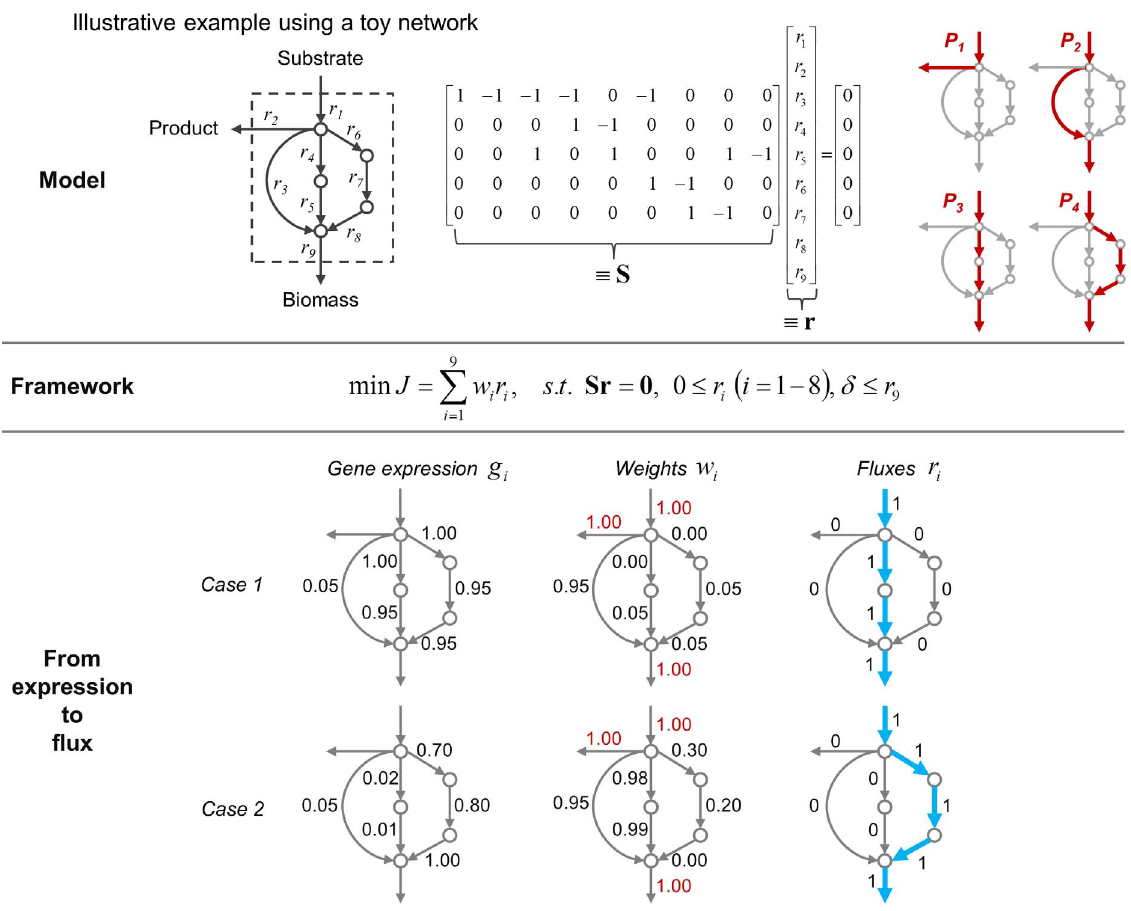
Figure 2. Toy example illustrating an implementation of the E-Fmin algorithm. The network model includes nine reactions ( r 1 to r 9 ) but only five available stoichiometric constraints among the five intracellular metabolites under the steady-state assumption. E-Fmin determines the full flux vector for this undetermined system by solving a linear programming problem such that a weighted sum of flux magnitudes is minimized while biomass production (i.e., r 9 in this example) carries nonzero flux. Given two sets of transcriptomic data, E-Fmin generates different flux distributions (denoted by thick arrows). The weight to the i th reaction ( w i ) is formulated as a decreasing function of the associated gene expression level ( g i ), i.e., w i =1 – g i . The weights highlighted in red represent the reactions for which no associated gene expression data are available. Table 1, we obtained a P value of , 10 2 10 and rejected the null hypothesis that the ranking of average correlation coefficients in Table 2 could arise by chance alone. The classical FBA (without flux minimization) performed poorly because some of the fluxes attained their upper (or lower) bound values, a problem associated with the existence of multiple LP solutions. These outliers were removed by applying the flux minimization as a secondary objective. Consequently, with the flux minimization, FBA provides reliable estimates, implying that the hypothesis of maximal biomass production may be valid for E. coli growing under these specific conditions. Interestingly, despite using the same objective function, the prediction of E-Flux was not comparable to that of FBA. It seems that the E-Flux predictions in this system are more affected by the imposed flux bounds than the choice of objective function. Algorithms based on the direct association with expression levels, such as in Lee et al., showed weak predictive powers, which may be ascribed in part to the use of gene expression data covering only the central carbon metabolism.